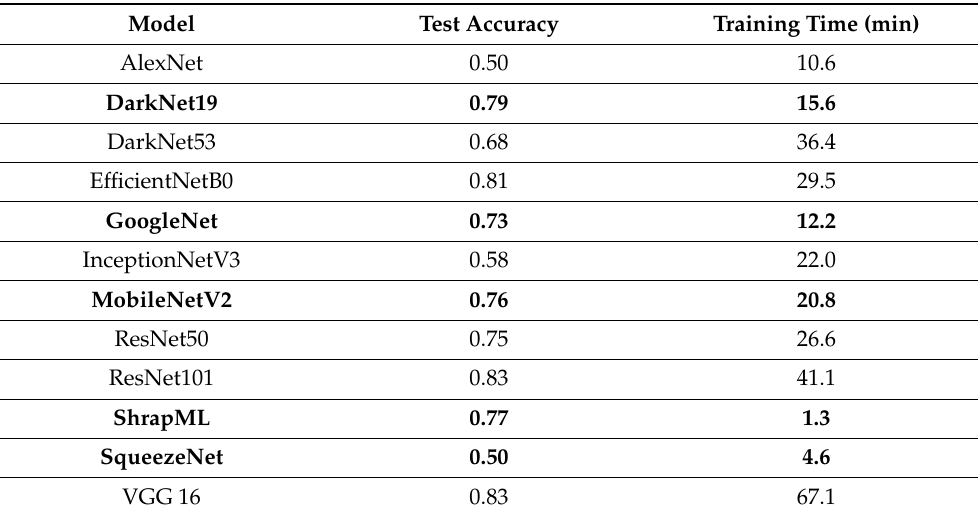
Table 5. Performance values of accuracy obtained during testing and time needed to train the 12 models from initial experimental training using five epochs. The five selected models are indicated in